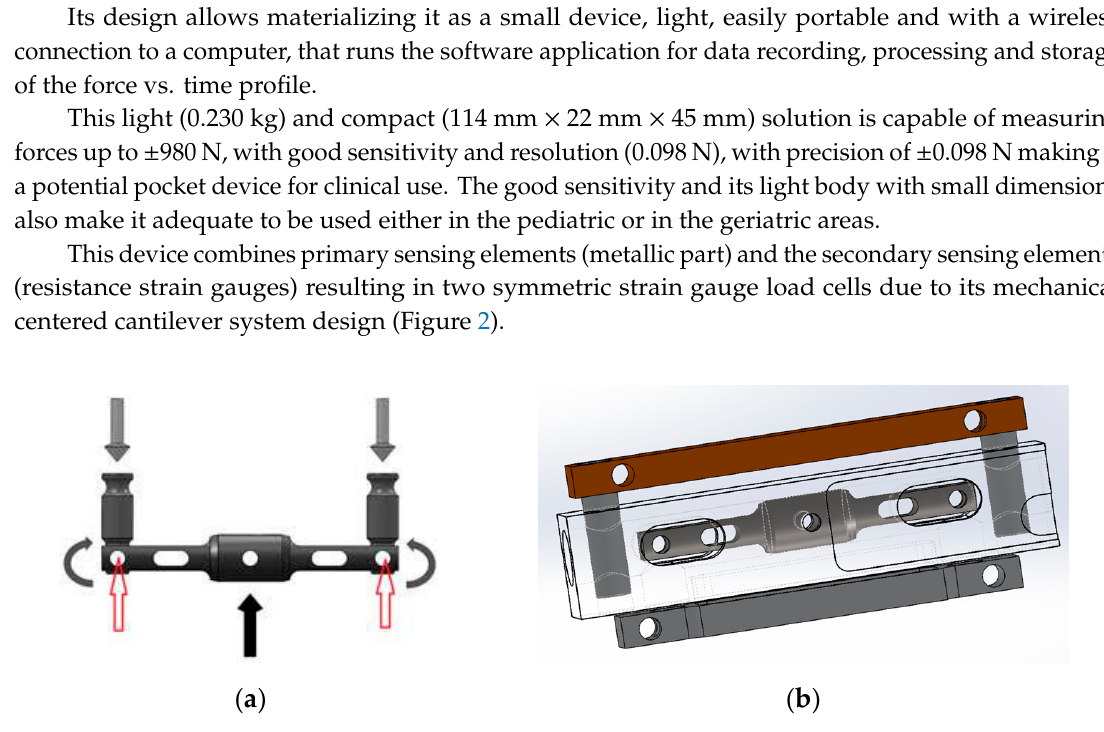
Figure 2. Schematic perspectives of the device design: the novel load cell ( a ) and device housing ( b ).